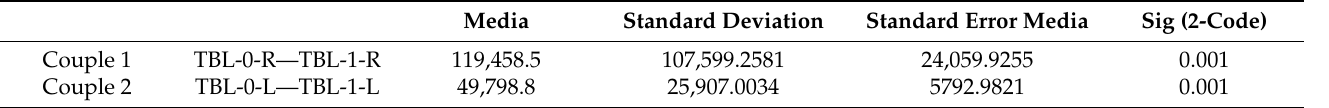
Table 3. CAL and PD values after treatment with SRP alone and SRP plus ALADENT: Results are statistically significant at * p value < 0.01.